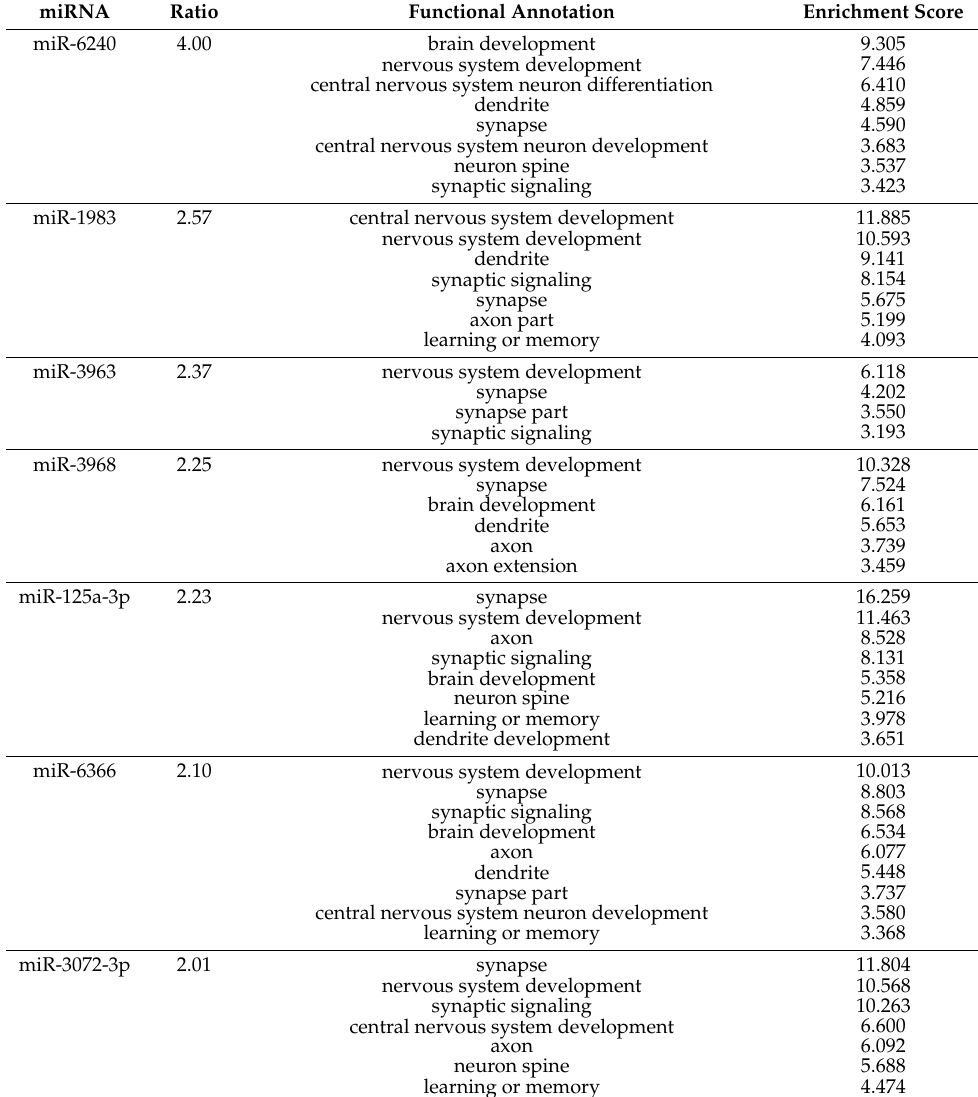
Table 1. Functional annotation of genes regulated by